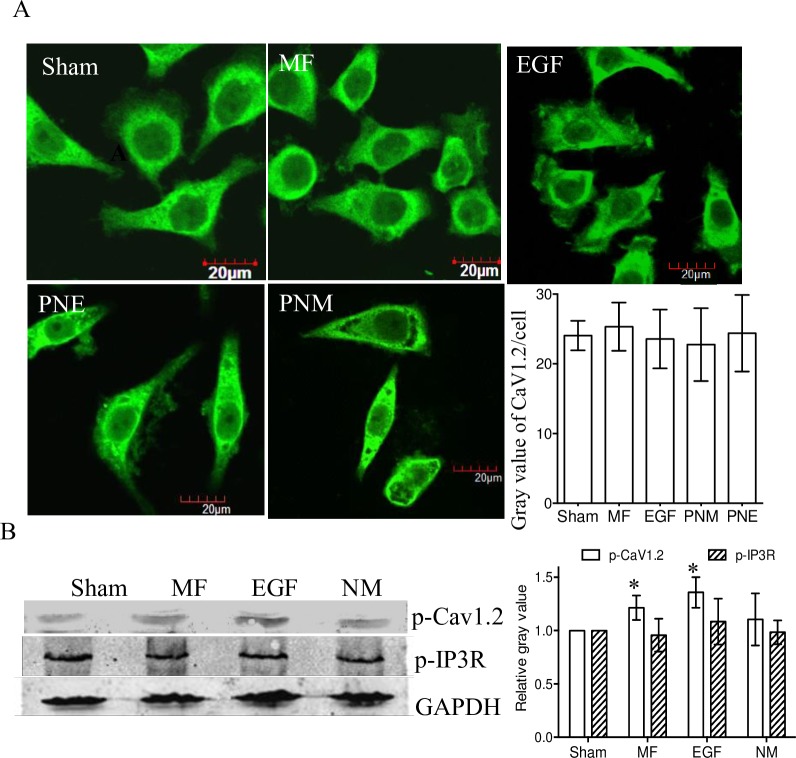
Effects of MF on CaV1.2 and IP3R.A: Immunofluorescence staining of CaV1.2 subunit of LTCC in FL cells. The groups were treated as described in Fig 1 and in Materials and Methods. The horizontal line represents 20 μm; average gray value of CaV1.2 per cell in at least 50 cells in each condition was quantified in the histogram; p-value > 0.05 when compared with Sham. B: Western blot assay (left) of p-CaV1.2 (top lane) and p-IP3R (middle lane) in FL cells; Sham: sham-exposed; MF: exposed to 0.4 mT MF for 30 min; EGF: treated with 100 nM EGF for 30 min; NM: pretreated with 0.02 mM NIF for 40 min, then exposed to 0.4 mT 50 Hz MF for 30 min. Relative gray value / content of the proteins to the Sham groups after normalized with the GAPDH was shown in the histogram (right). *: p-value < 0.05 by Student’s t-test when compared with Sham. Details of the analyzed cell number and repeat times were listed in S1 Table.